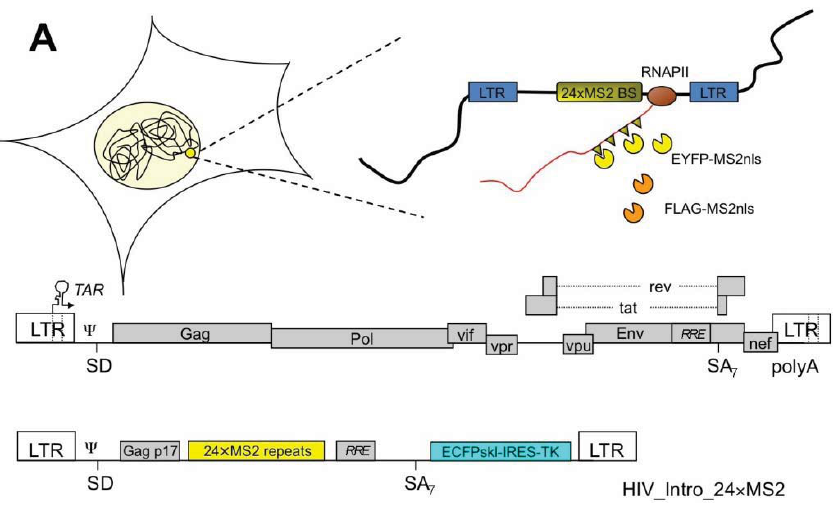
expressing EYFP-MS2nls; ( c ) Localization of SF2 on HIV-1 RNA at the transcription site. MS2 (white arrow) in U2OS cell clones expressing Tat and